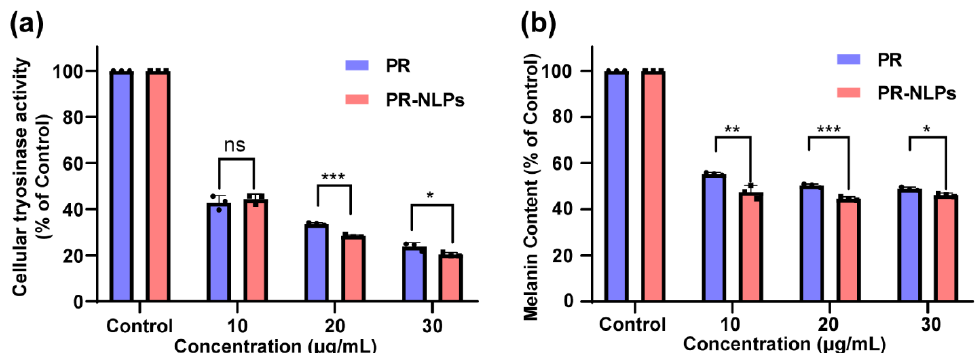
Figure 10. ( a ) Effect of PR-NLPs on tyrosinase activity in B16F10 cells, compared with PR solution. ( b ) Effect of PR-NLPs on melanin content in B16F10 cells, compared with PR solution (n = 3, * p < 0.05, ** p < 0.01, *** p < 0.001).